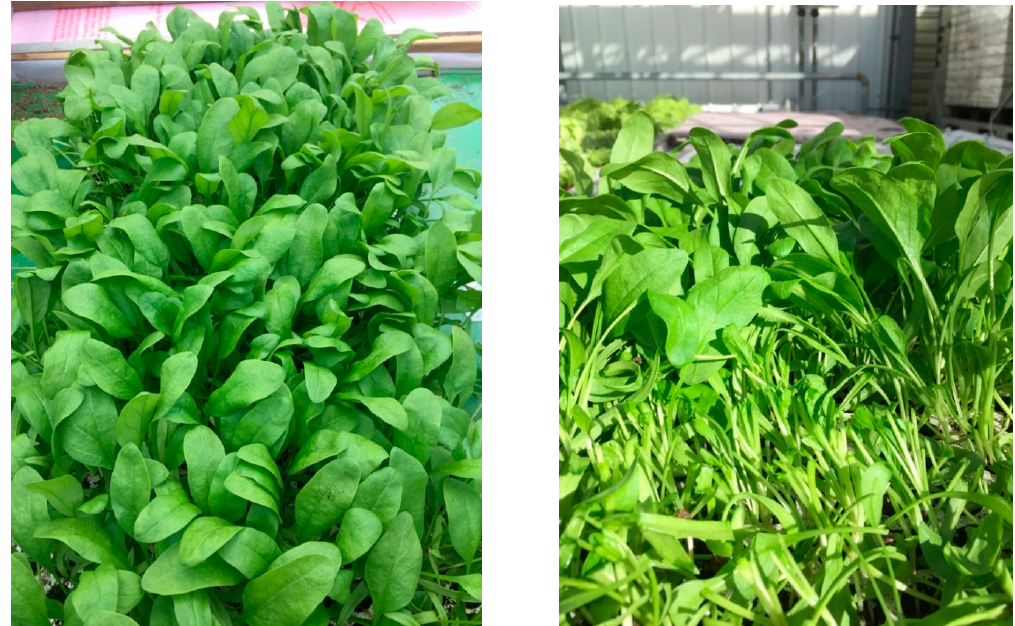
Figure 7. Before and mid-harvest of Carmel; some small second true leaves are left behind low in the canopy.